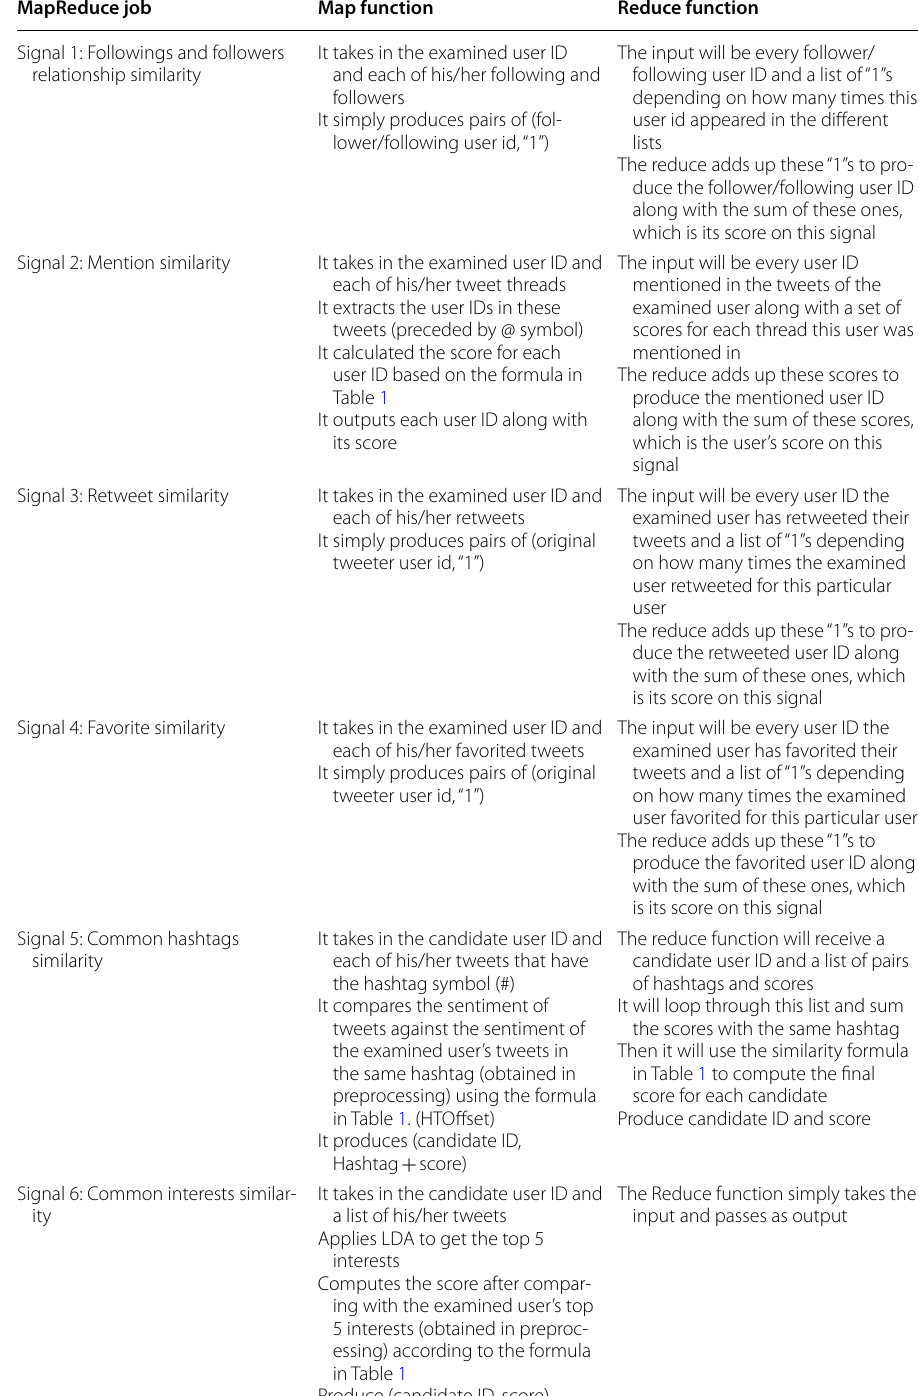
Table 2 Brief descriptions of the map and the reduce functions used in processing each signal MapReduce job Map